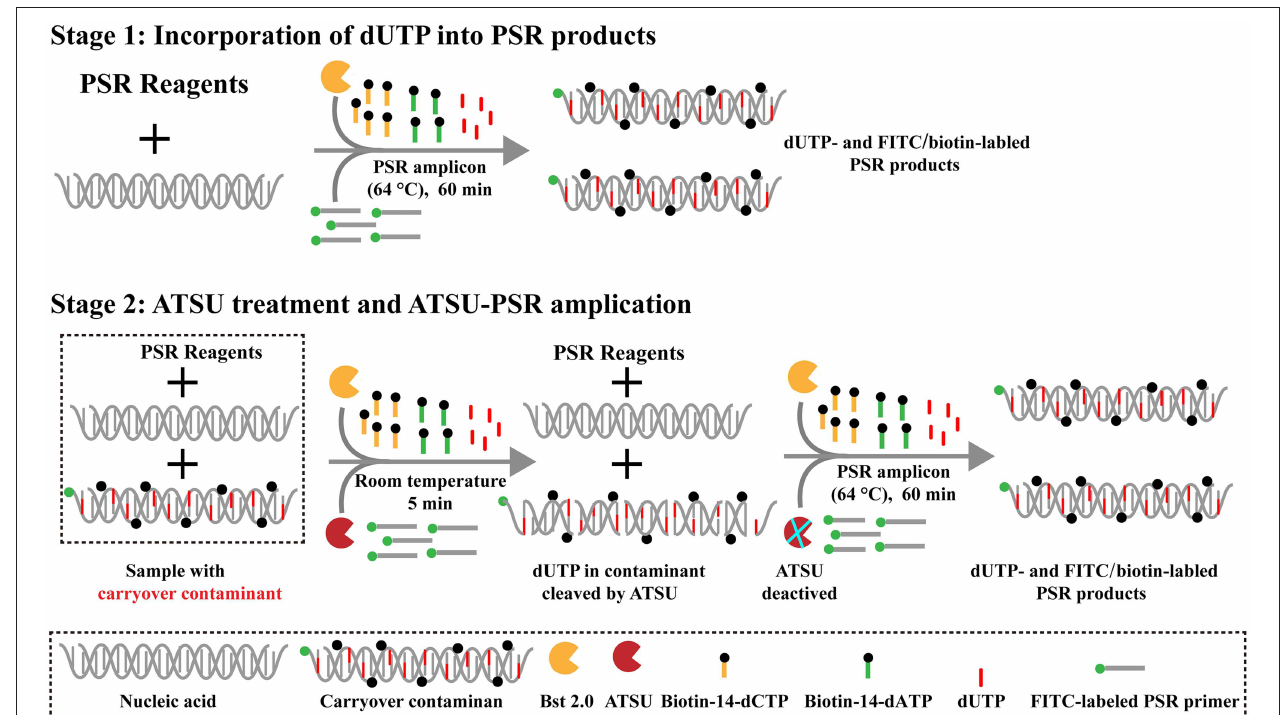
FIGURE 3 | Schematic illustration of the principle of antarctic thermal-sensitive uracil-DNA-glycosylase-supplemented polymerase spiral reaction (ATSU-PSR) technique for eliminating carryover contamination. Two steps are needed for ATSU-PSR technique for removing carryover contamination. During the first stage, all PSR complicons labeled with dUTP in the presence of Bst 2.0 enzyme and dUTP. During the second stage, all subsequent ATSU-PSR amplifications are digested using ATSU, which specifically cleave carryover contaminants by removing uracil in amplicons from previous reactions. Importantly, ATSU is heat inactivated during the PSR amplification stage (63 ◦ C), and the digested contaminants are degraded, ensuring that only the target templates are amplified. In addition, three components, including fluorescein isothiocyanate (FITC)-labeled primer, biotin-14-dCTP, and biotin-14-dATP, are added into ATSU-PSR mixtures for forming the biotin- and FITC-attached duplex